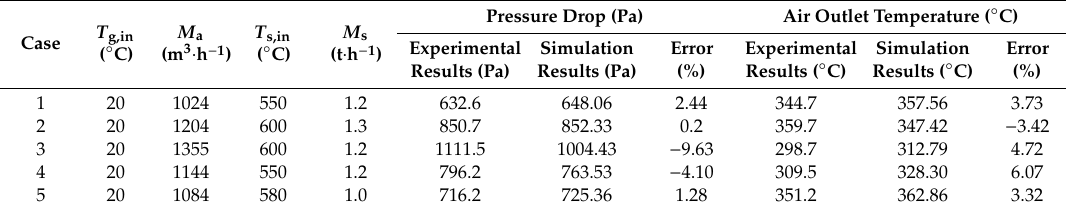
Table 4. Comparison of the results from the simulation and experiment.